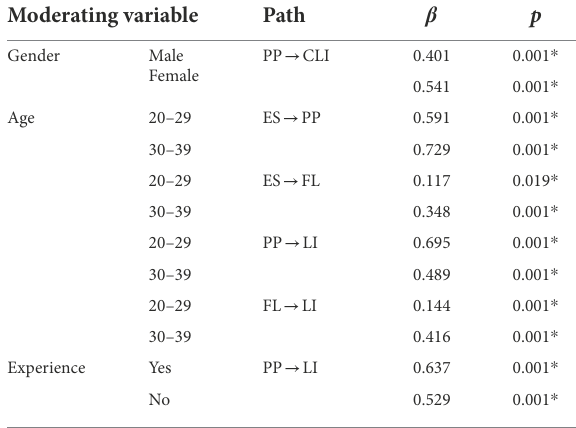
TABLE 11 Comparison between path coefficients with significant moderating